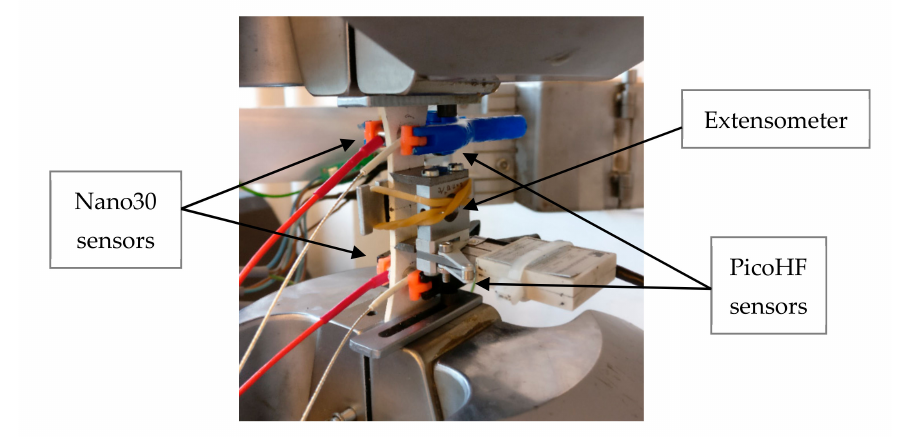
Figure 2. Multi-sensor acoustic emission (AE) monitoring during macroscopic tensile test.